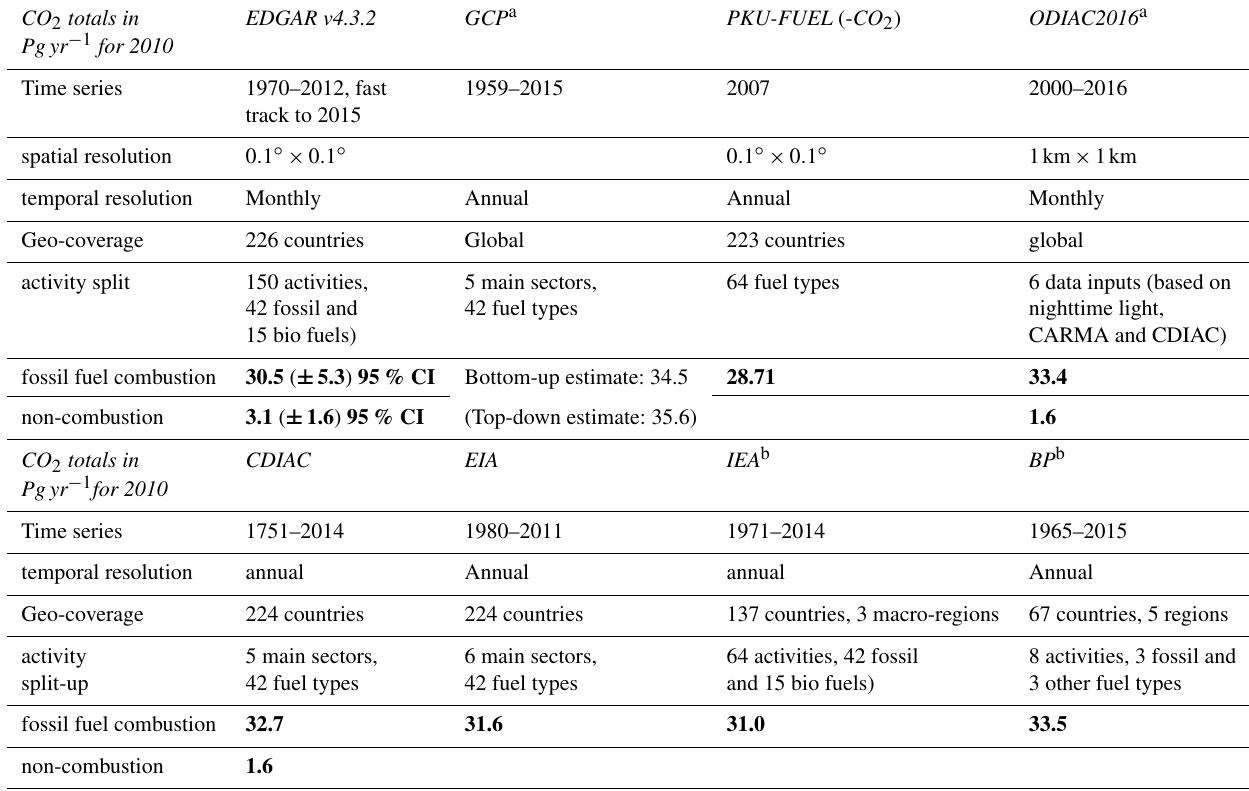
Table 3. Intercomparison of eight global CO 2 datasets (GCP, Le Quéré et al., 2016; PKU-FUEL, Wang et al., 2013; ODIAC2016, Oda et al., 2018; CDIAC, Andres et al., 2014; EIA, 2014; IEA, 2014; BP, 2017) with regard to their spatial and temporal coverage and their estimate of the global total Pg CO 2 per source for 2010 (and 2007 for